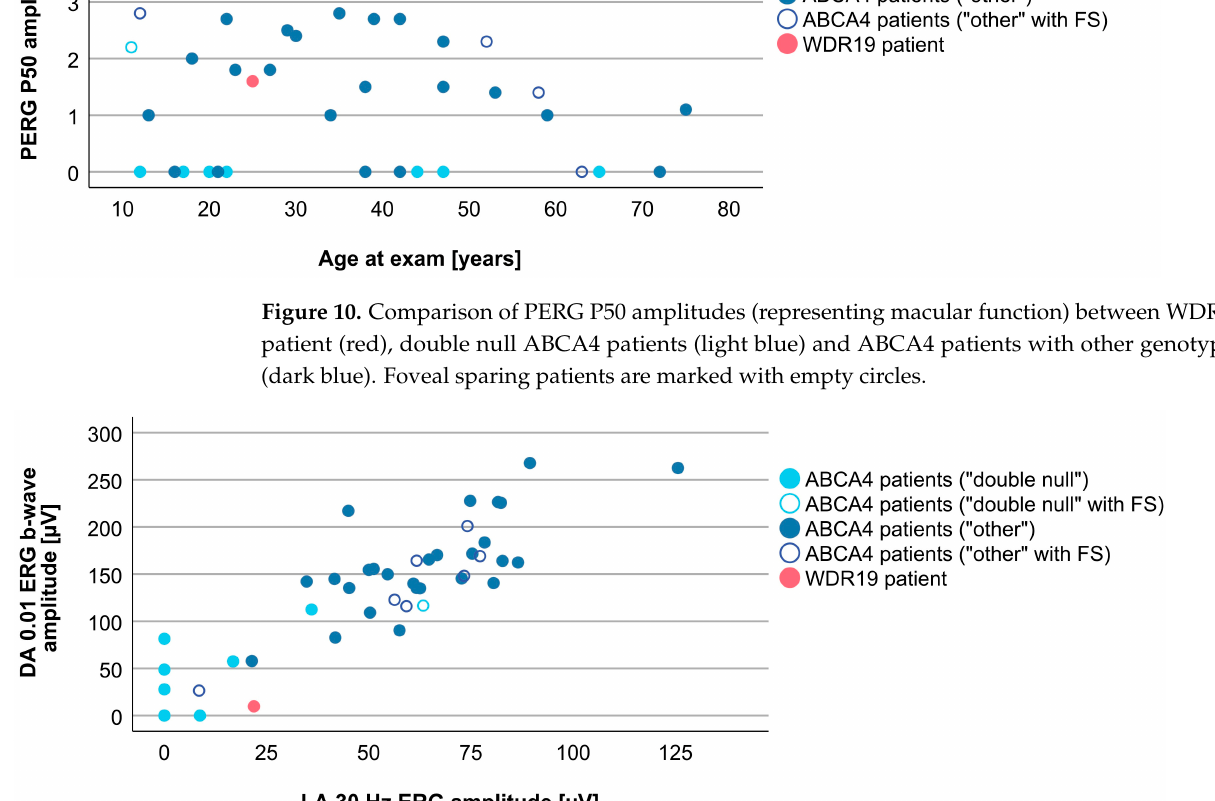
Figure 11. Different ratios of cones and rods impairment in WDR19 patient (red), double null ABCA4 patients (light blue) and ABCA4 patients with other genotypes (dark blue). Foveal sparing patients are marked with empty circles.